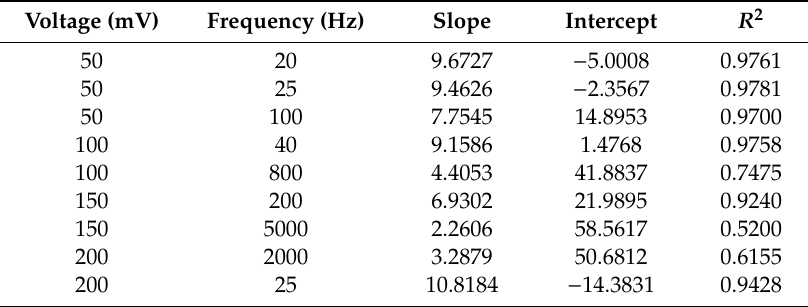
Figure 9. ( a ) Correlation between capacitance and cell concentration at driving voltage of 50 mV and frequency of 20 Hz; ( b ) Optimal linear fitting between − △ C ( y -axis) and the logarithmic scale of cell concentration ( x -axis) is observed in the range of 10 3 –10 6 CFU · mL − 1 at the driving voltage of 50 mV and frequency of 20 Hz. Table 2. Some results of linear fitting.